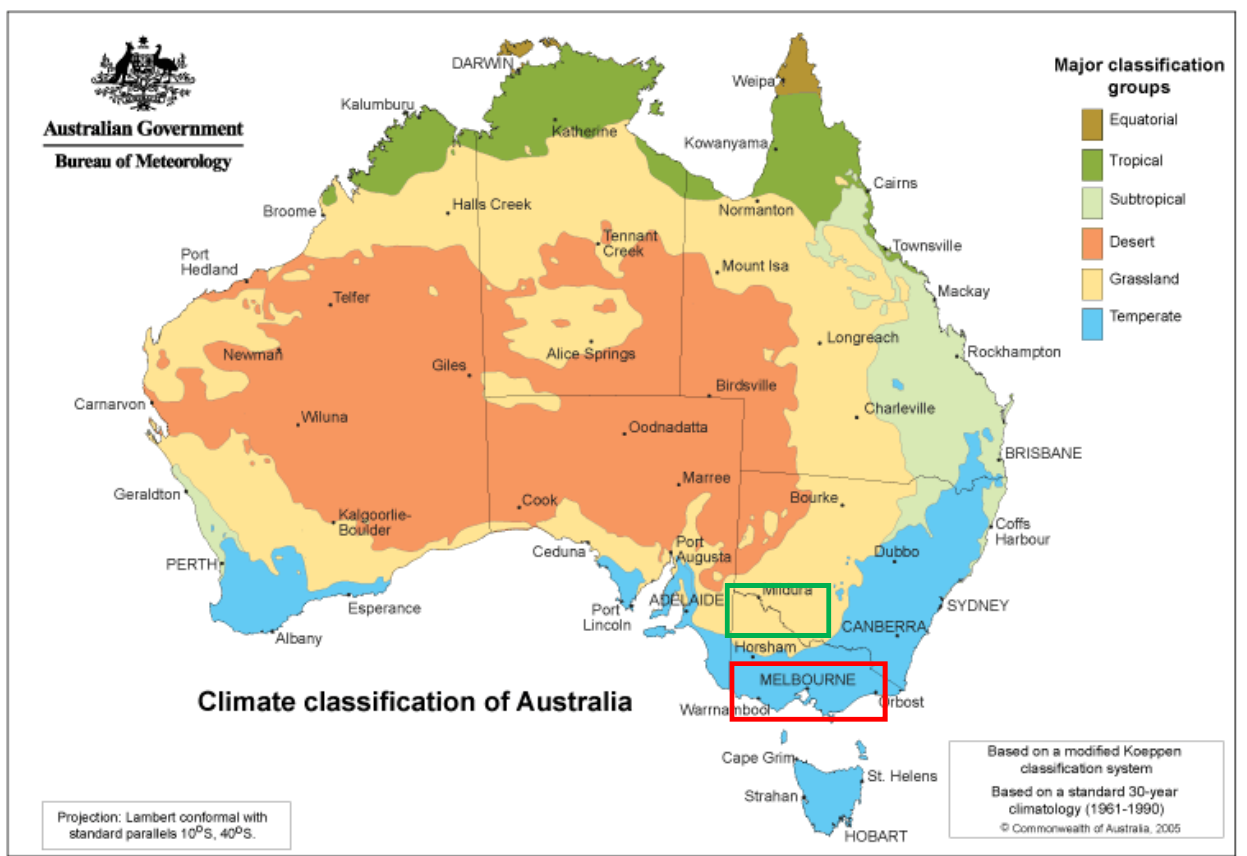
Figure 1. Geographical Visualization of Temperate Region of Australia (highlighted in red) and Grassland Region of Australia (highlighted in green).